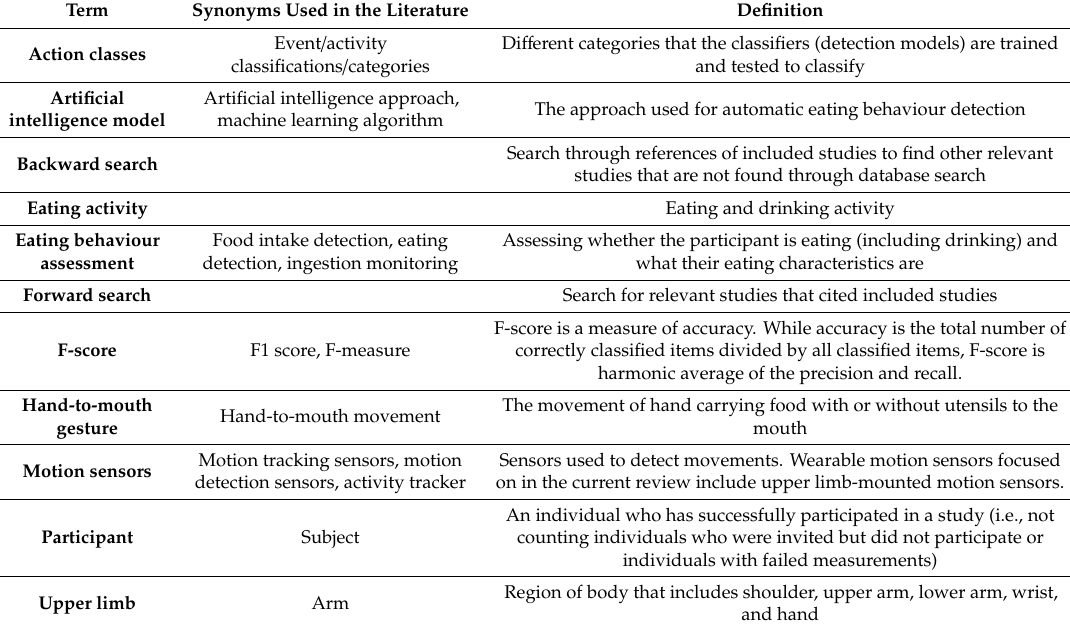
Table 1. Terms used in this review with synonyms and